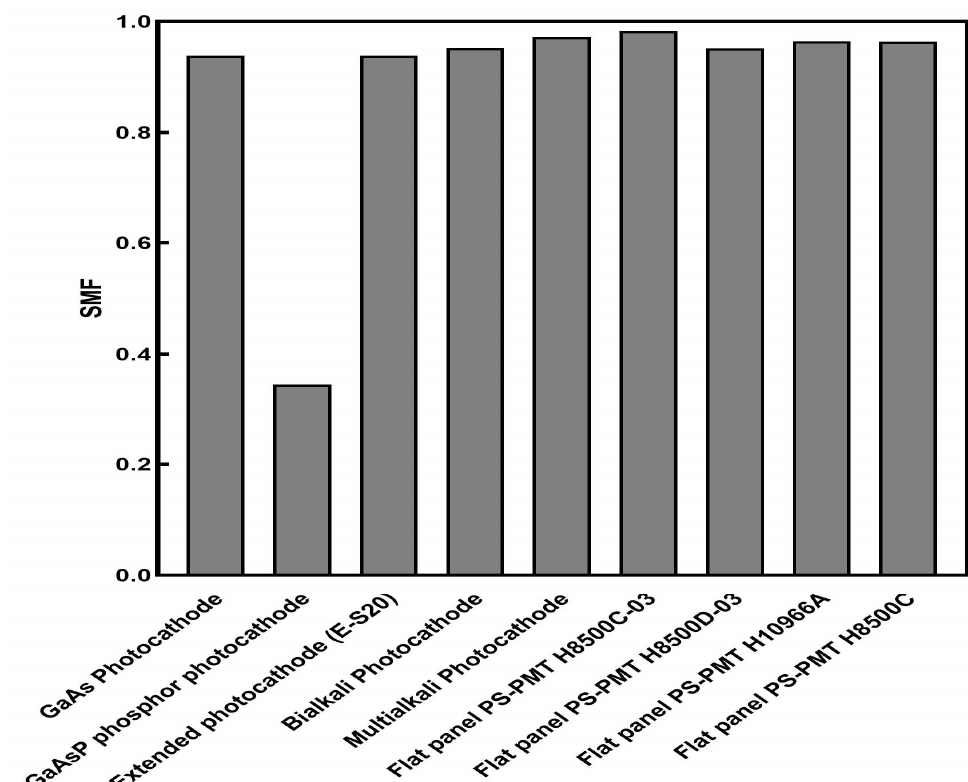
Figure 13. SMF values of LaBr 3 :Ce with various photocathodes.